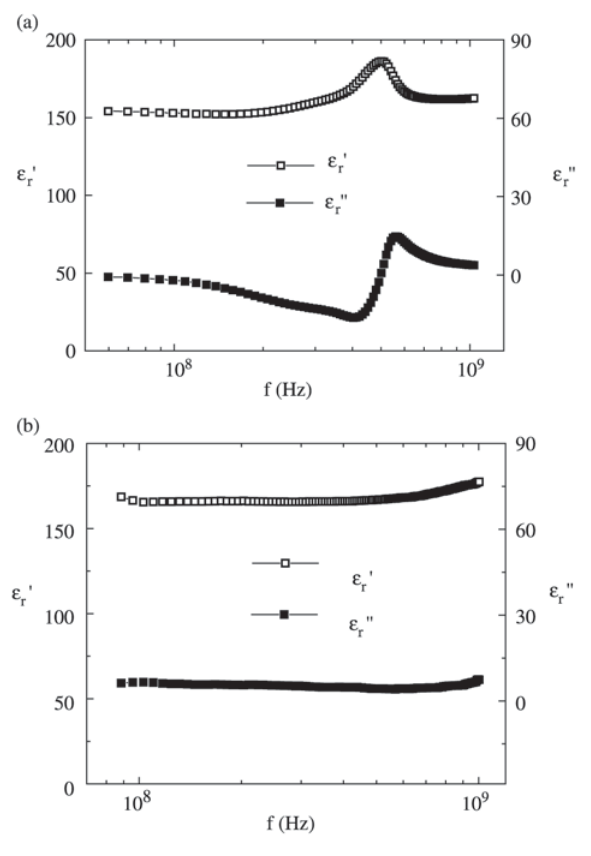
Figure 4. Dielectric response of the PLTM ferroelectric ceramic for two pressure levels on sample: Pa > Pb. Pb is in the limit of the minimum pressure necessary for the elimination of resonant ef- fects.